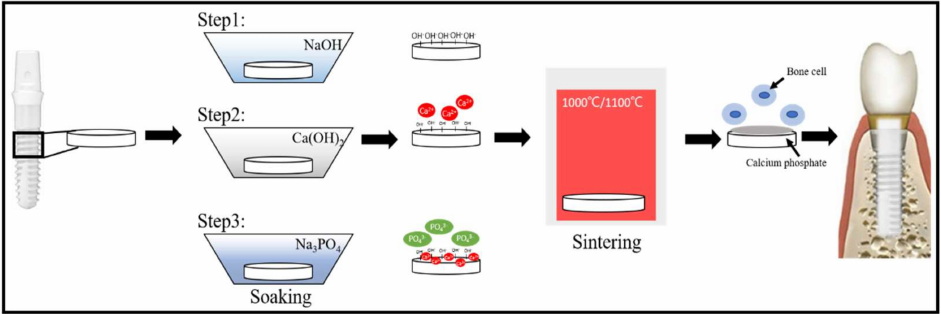
Figure 1. Graphic abstract of this study.